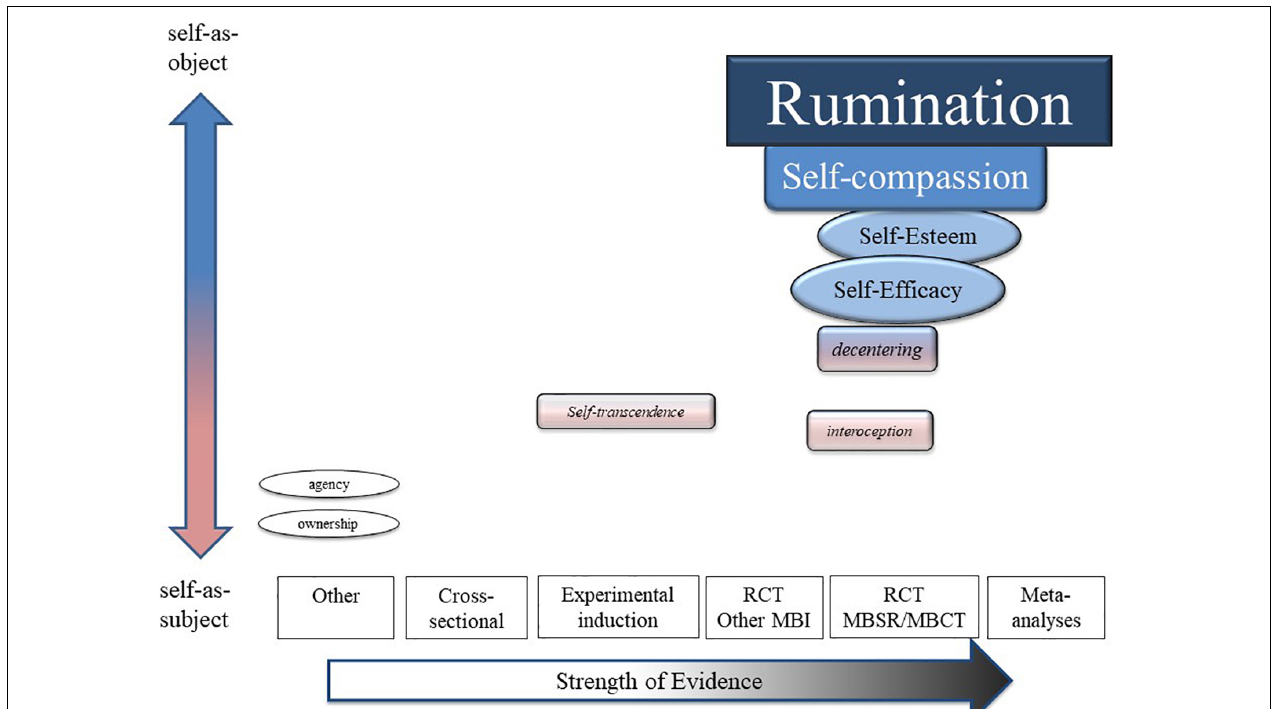
FIGURE 2 | Evidence